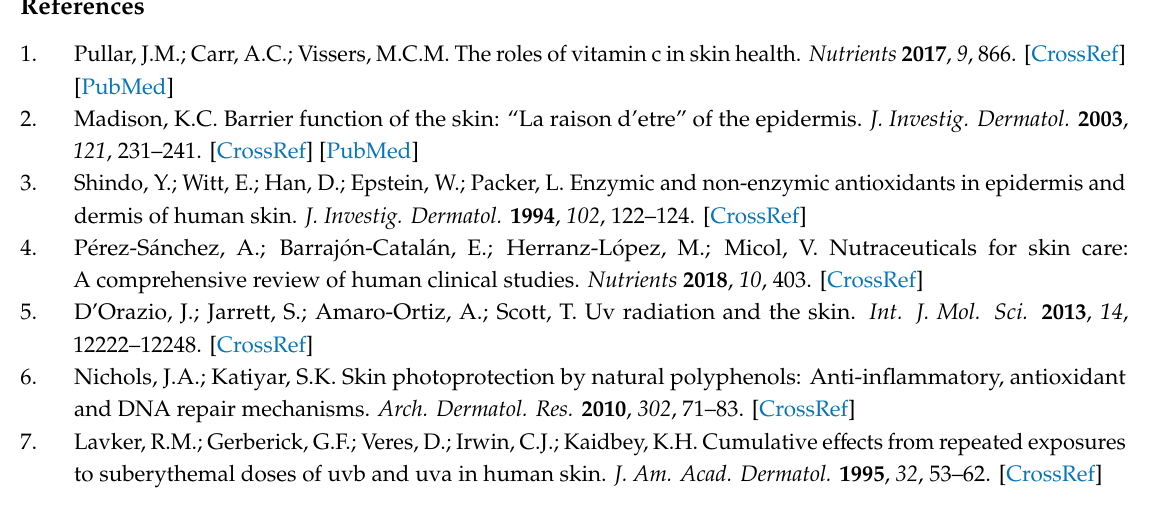
Figure S1. Polyphenol (soft green) and flavonoid (dark green) classification (A) and apigenin basic structure and main biological e ff ects